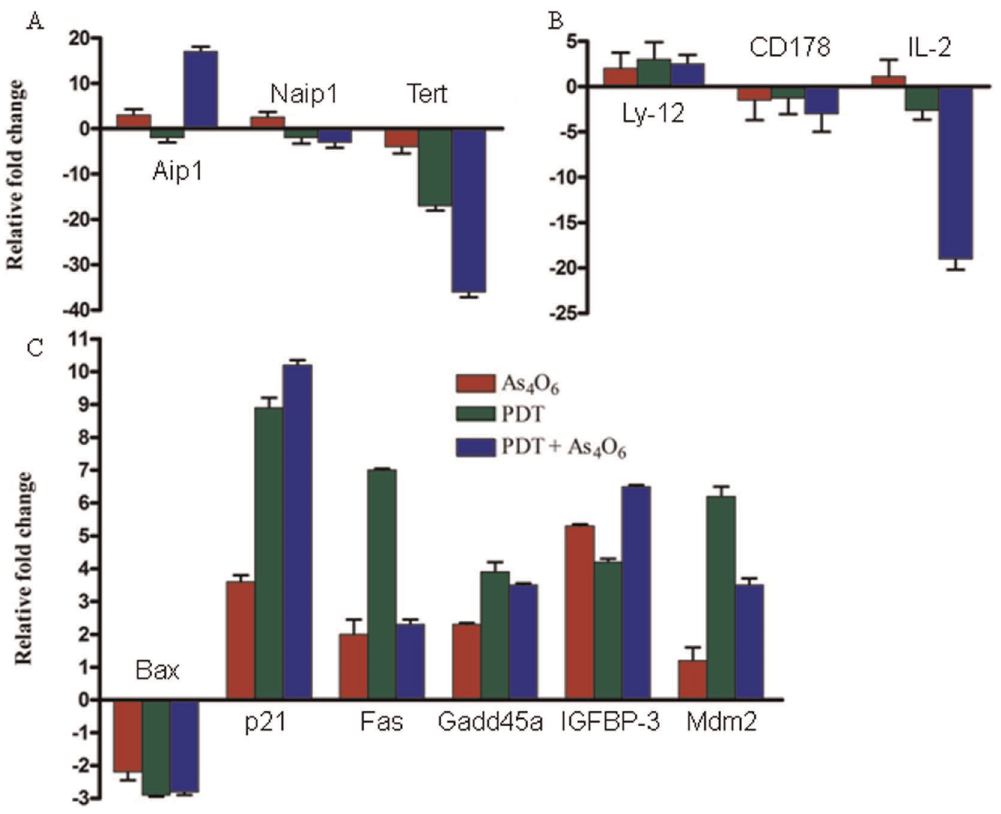
Figure 4. Invitro gene expression profiles using RT 2 Profiler TM PCR array of TC-1 cells treated with 0.15 ug/ml Radachlorin/PDT or/ and 3 uM of As 4 O 6 for 1 day. The results are presented as transcript levels relative to the level in untreated control cells by using the CT method, with average mRNA level of five internal control genes, including b-actin, used as the normalization control. (A) Cell survival pathway. (B) NEAT pathway. (C) p53 pathway.